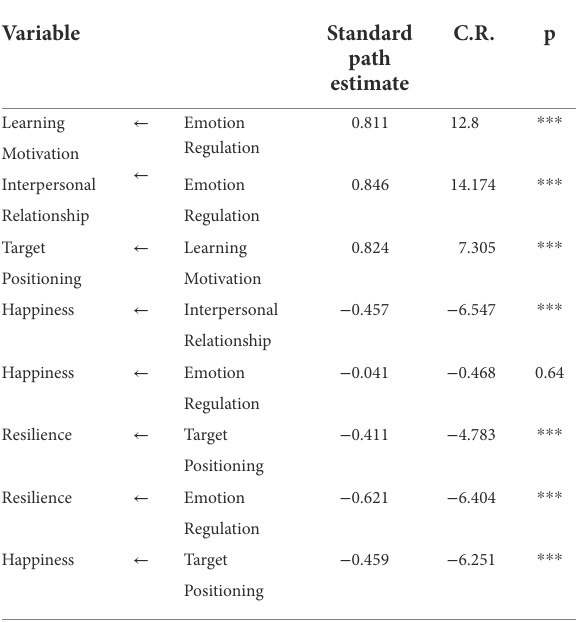
TABLE 5 The effect relationship between the factors in the fitted